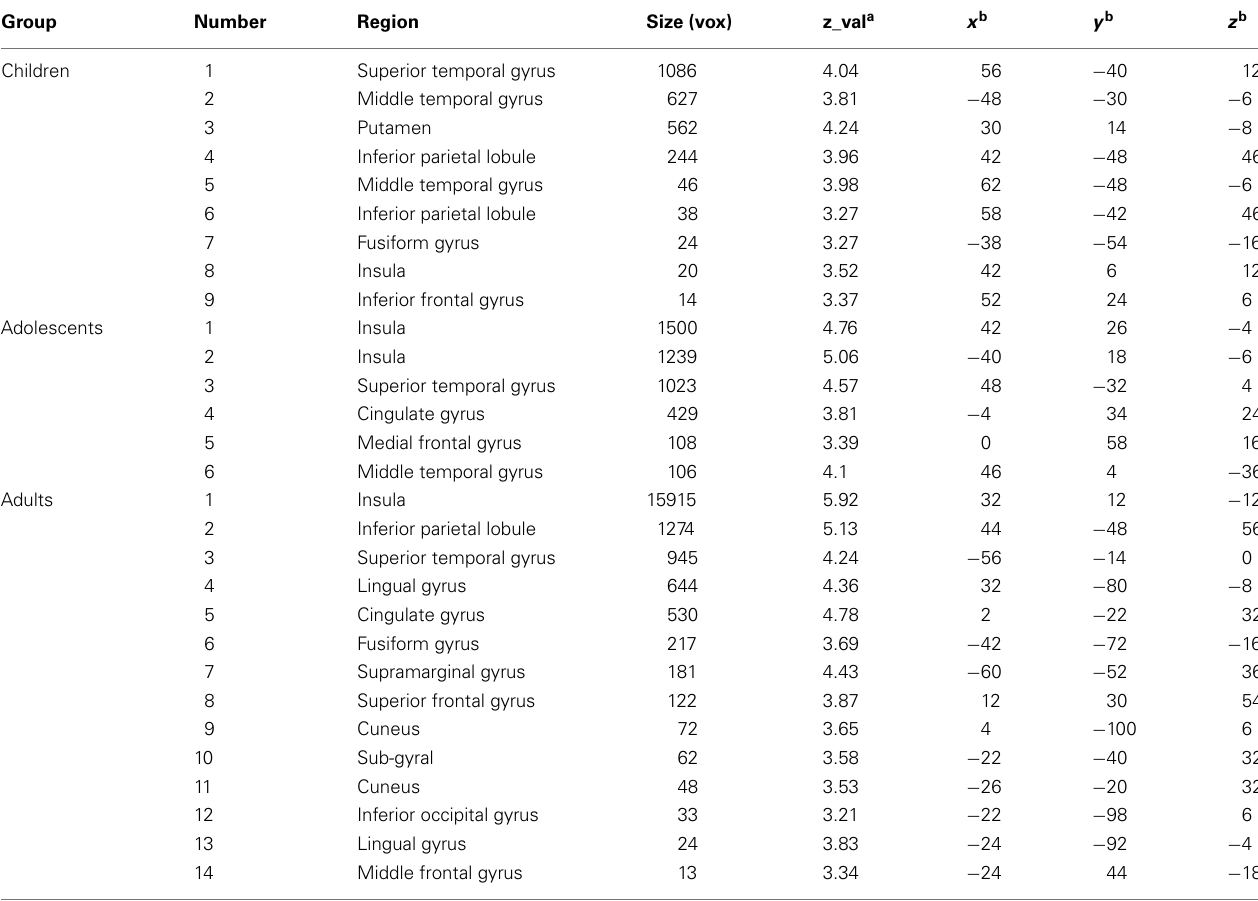
TableA3 |Activation to losing outcomes by age group.